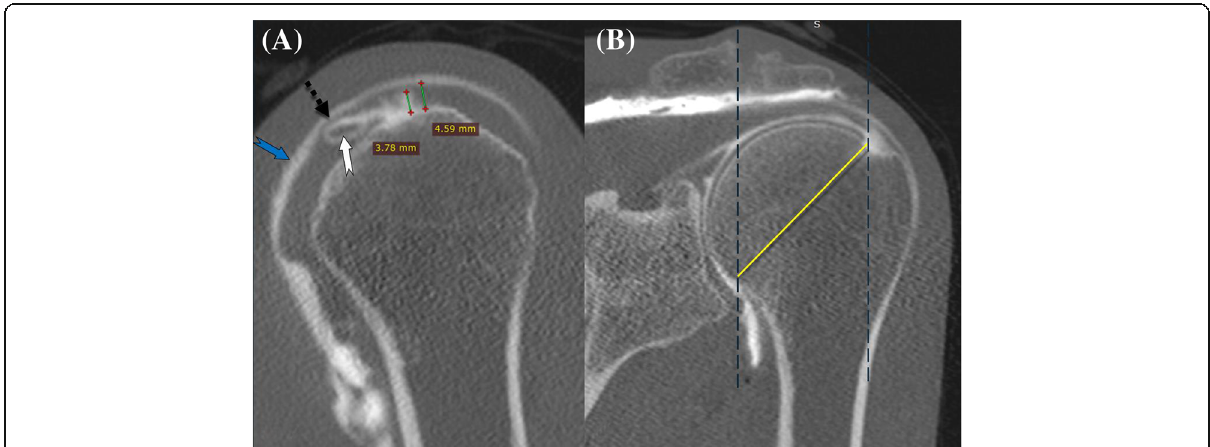
Fig. 2 Sagittal oblique ( a ) and coronal oblique CT arthrographic images ( b ) through the supraspinatus tendon, in a 47 years old male patient complained from left shoulder pain increased on arm lifting, there is a simple partial - thickness articular surface tear of supraspinatus tendon at its footprint affecting 82% of its thickness. Note the potential for percentage affection measurement was got by virtue of contrast highlighting of tendon bursal surface from bursography (blue arrow). Biceps long head tendon (white arrow) is easily depicted within the rotator interval with overlying coraco-humeral ligament (dashed black arrow)